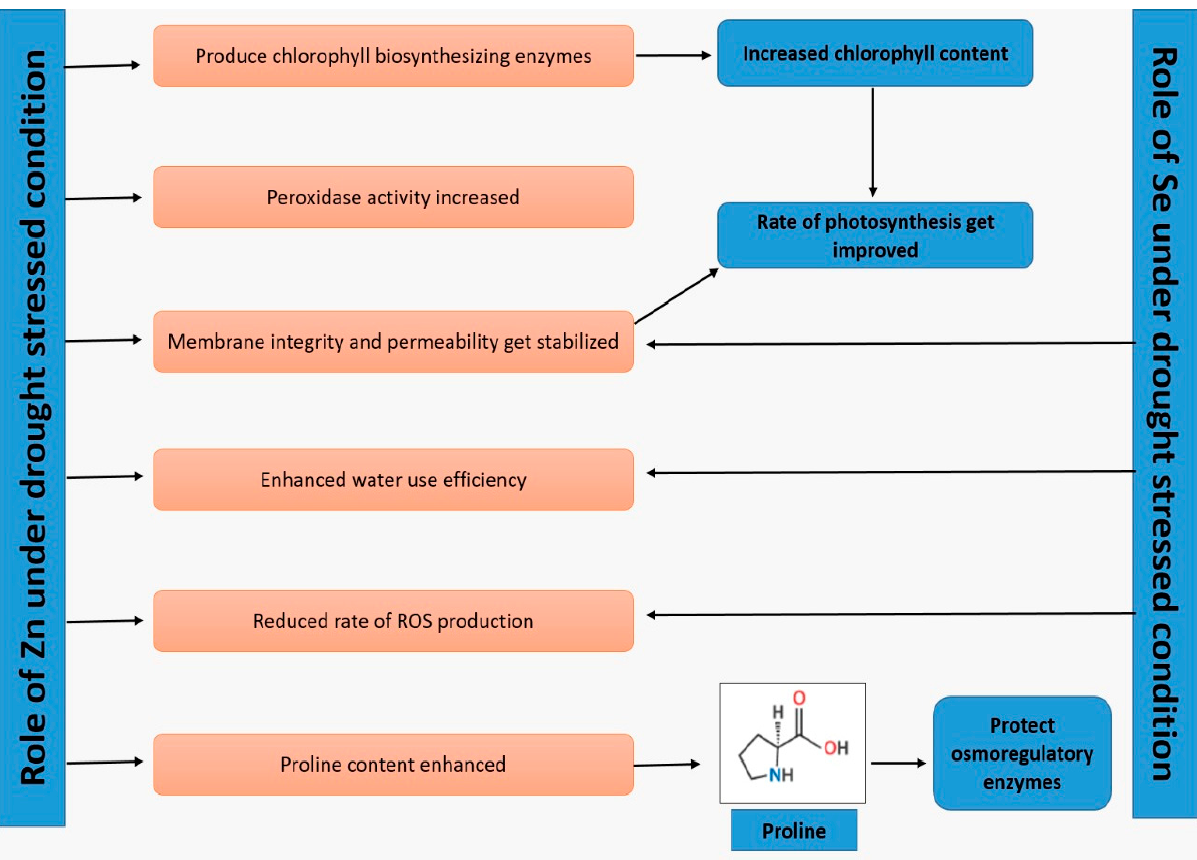
Figure 5. Diagram showing how Zn and Se help the plants alleviate and overcome the adverse effects of drought.